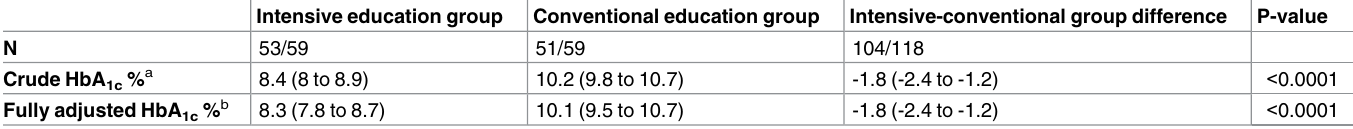
Table 2. Multiple regression results for HbA 1c outcomes at six-month follow-up for participants in the intensive and conventional education